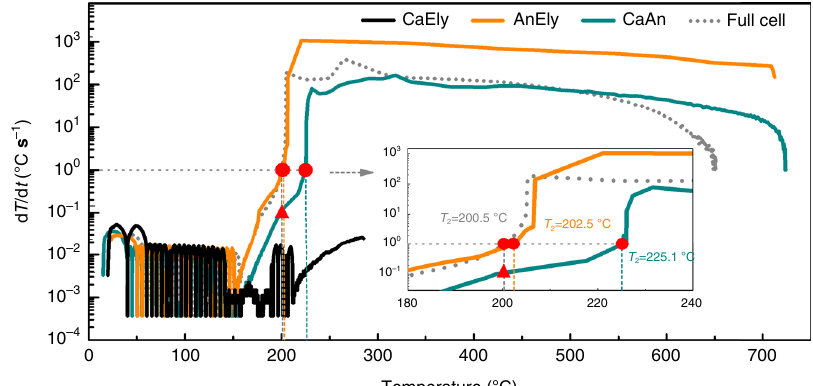
Fig. 3 Comparison of thermal runaway features of CaEly, AnEly, and CaAn partial cells with full cell. AnEly, CaEly, and CaAn partial cells were prepared from the fully charged Gr|NMC811 batteries to investigate the contribution of different exothermic reactions during the thermal runaway process of the battery. The temperature dependence of d T /d t between the full cell (dot line in gray) and the partial cells was compared. No electrolyte in the CaAn cell, while the concentrated LiFSI/DMC electrolyte was used for all the other partial cells and the full